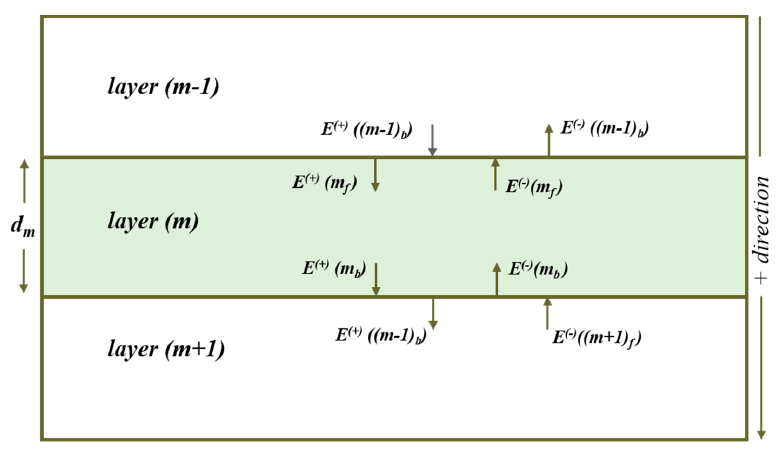
Figure 2. A general multilayer structure having z layers of thickness d m drawn assuming normal incidence.